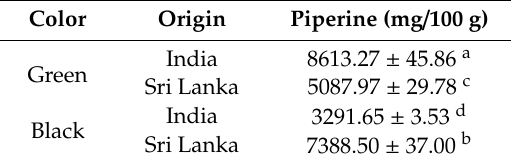
Table 3. Piperine contents of green and black